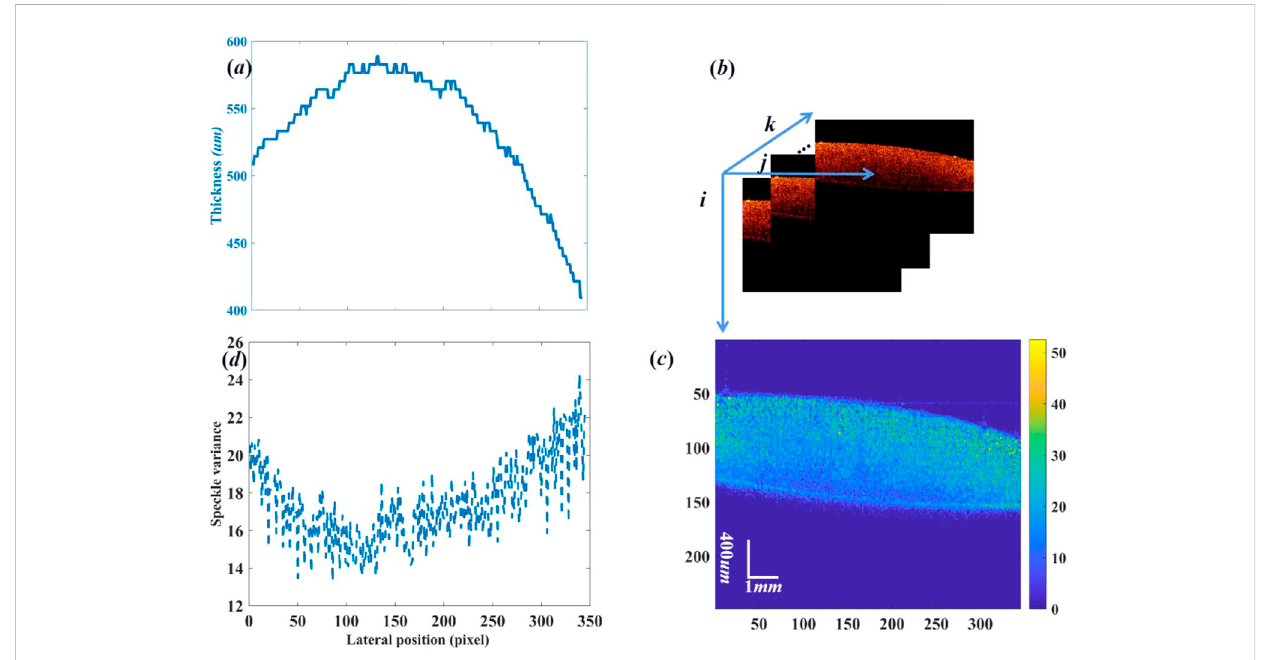
FIGURE 3 (A) Lateraldistributionofthepixel-wisethickness, (B) successivecross-sectionalOCTimages, (C) specklevarianceimage,and (D) lateraldistribution of the pixel-wise median of speckle variance of the whole